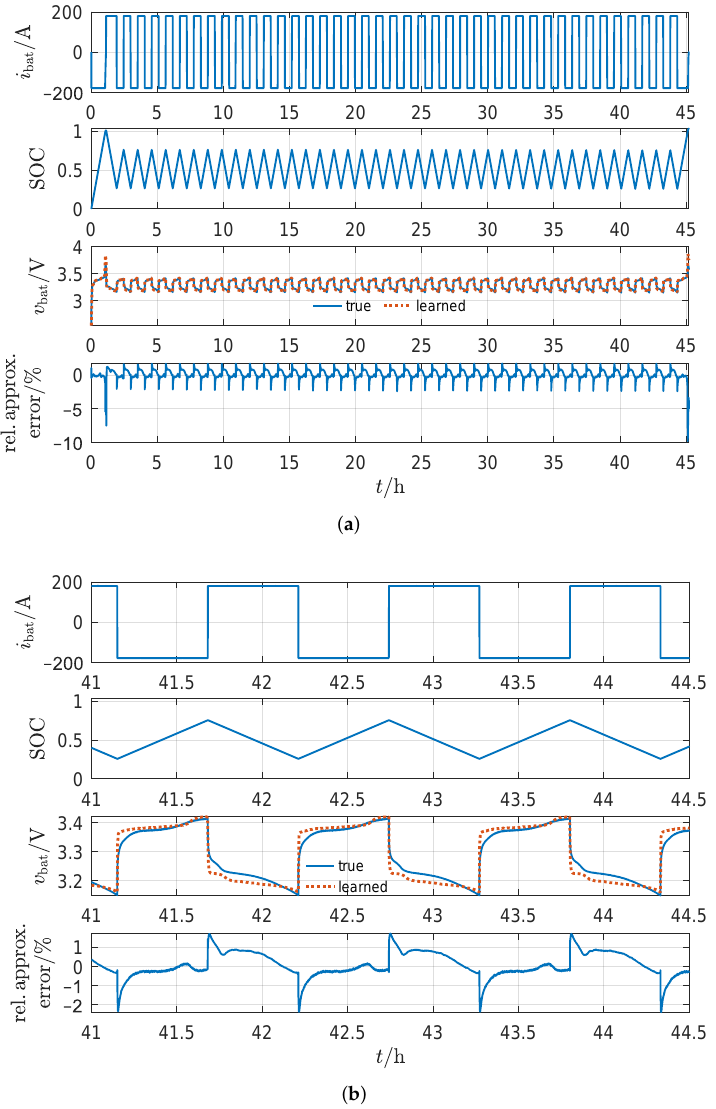
Figure 8. Test results in comparison to experimental data at T = 25°C for half cycles; ( a ) the complete time series; ( b ) focus on the last three half